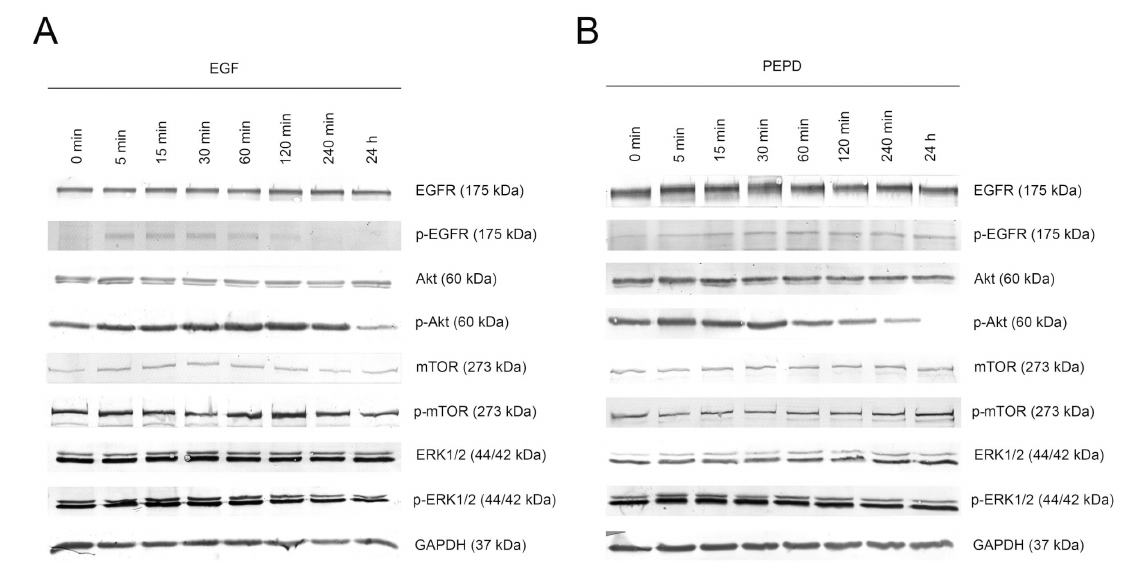
Figure 3. Kinetic analysis of phosphorylation of the epidermal growth factor receptor (EGFR) and its downstream signaling proteins induced by EGF ( A ) and PEPD ( B ) at concentration of 10 nM after 0, 5, 15, 30, 60, 120, and 240 min and 24 h upon supplementation. Representative blot images are shown (densitometric analysis of presented protein is included in Supplementary Materials (Supplementary Figure